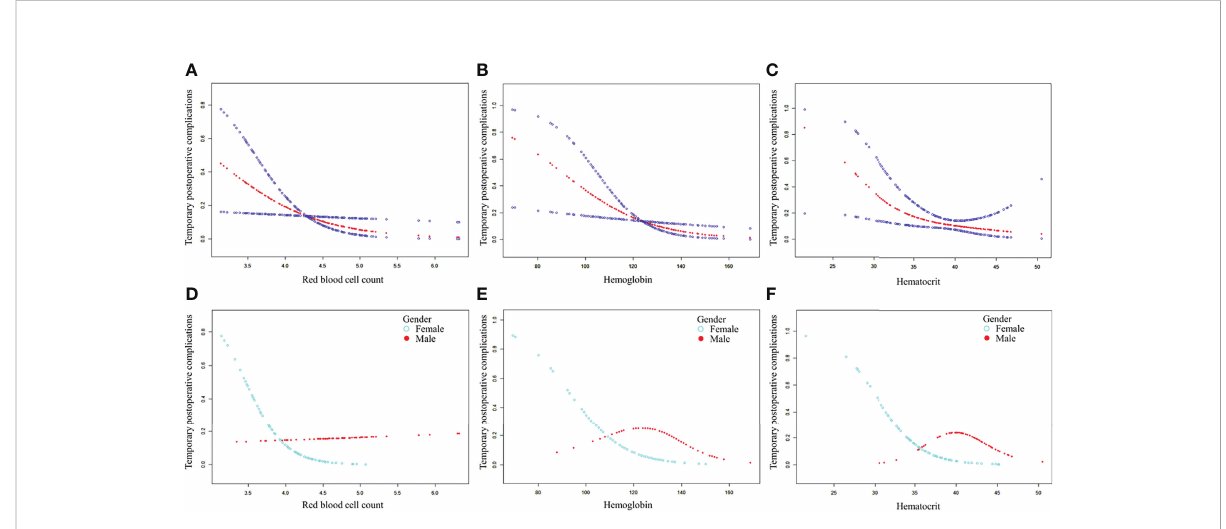
FIGURE 1 The association between blood routine indexes and temporary postoperative complications. Adjusted for age, gender, weight, length of operation, blood loss, body tumor location, and Shamblin type. (A – C) The association between postoperative red blood cell, hemoglobin, or hematocrit and temporary postoperative complications in total patients after CBT surgery. (D – F) The association between postoperative red blood cell, hemoglobin, or hematocrit and temporary postoperative complications in male and female patients after CBT surgery. CBT, carotid body